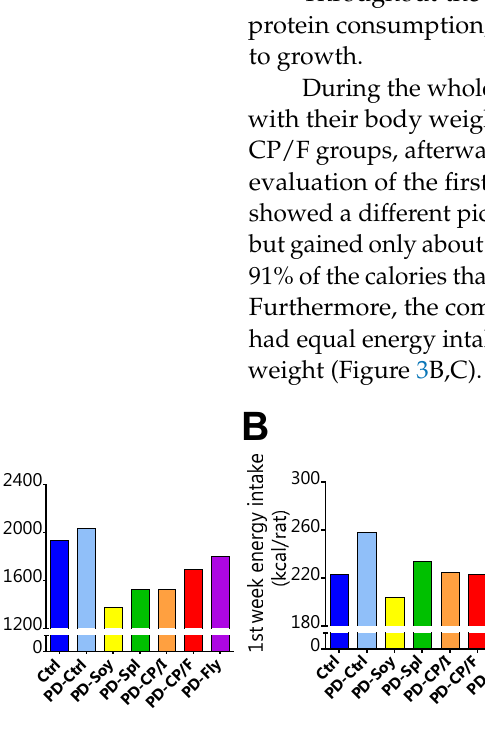
Table 3. Serum biochemistry analysis. ALP, Alkaline Phosphatase; ALT, Alanine Transaminase; AST, Aspartate Aminotransferase. Values are expressed as mean ± SD of n = 8 rat/group, different superscript letters are significantly different ( p < 0.05) by one-way ANOVA followed by Tukey’s test. Bold numbers significantly differ between diets and from the normal range.